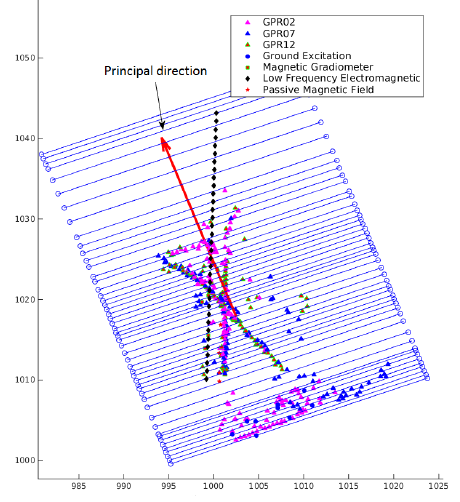
Figure 5. Virtual scan lines generated based on hypothesized detections from data of different surveys using five types of sensors. The main direction computed from the hypothesized detections is displayed as red bold arrow, and the virtual scan lines are shown as blue